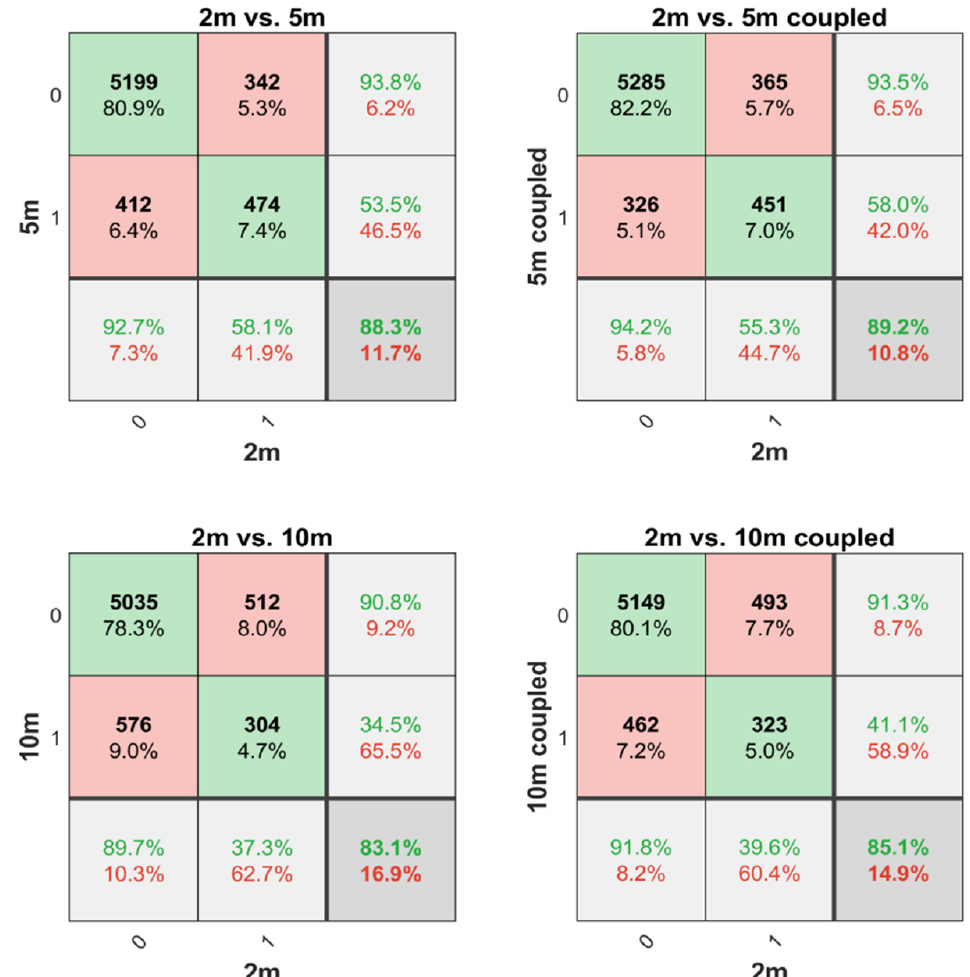
The comparison shows an improvement for all the GOFs. The 5 m coupled model approximates the 4 m model for the logNSE and r 2 . The 10 m model for these GOFs shows larger improvements and approximates the 7 m model for the logNSE, and has a slightly better value than the 7 m model for the r 2 . The largest improvements can be observed for the RMSE. The 5 m model has a smaller RMSE than the 3 m model, and the 10 m model shows similar values to the 4 m model. Figure 7 shows the confusion matrix for the first stage.